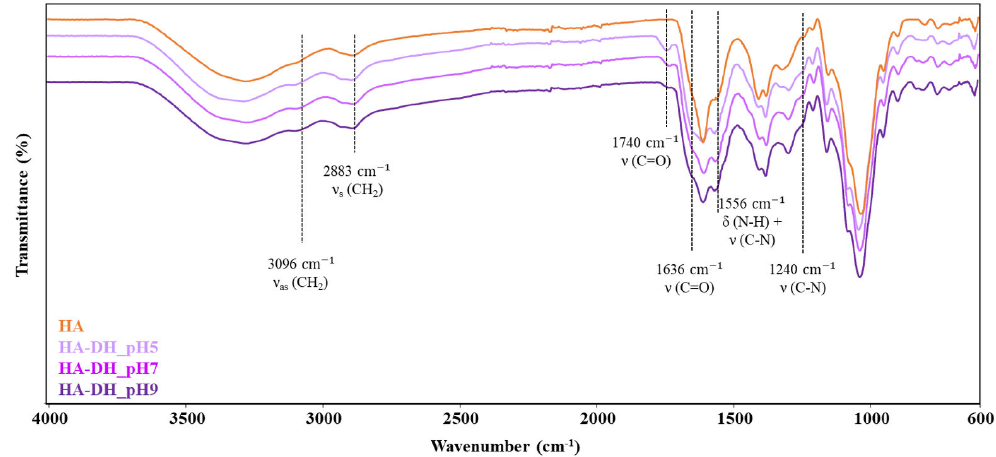
Figure 2. ATR-FTIR spectra of HA (orange), HA-DH_pH5 (light violet), HA-DH_pH7 (violet) and HA-DH_pH9 (dark violet). Black lines identify the wavenumber values in which HA-DH_pHX spectra exhibit major differences compared to HA spectrum